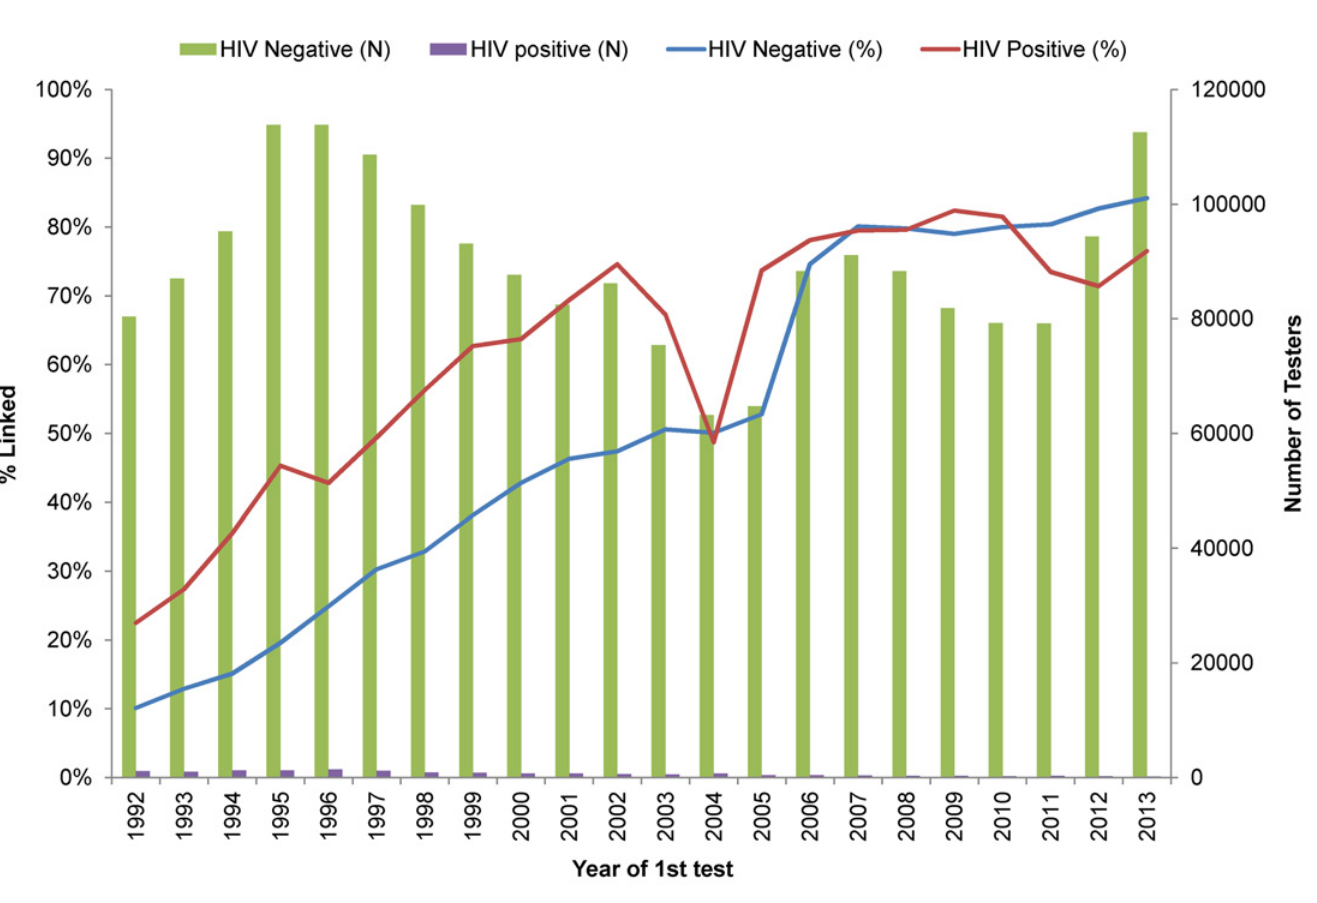
Fig 4. HIV laboratory data linkage rate by year 1992 –